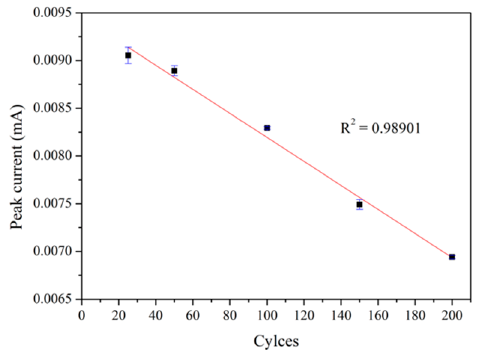
Figure 10. Peak current as a function of the number of cycles for the BaTiO 3 /MWCNT composite (2:1)-based electrode in 500 µM citric acid at a scan rate 100 mV/s.